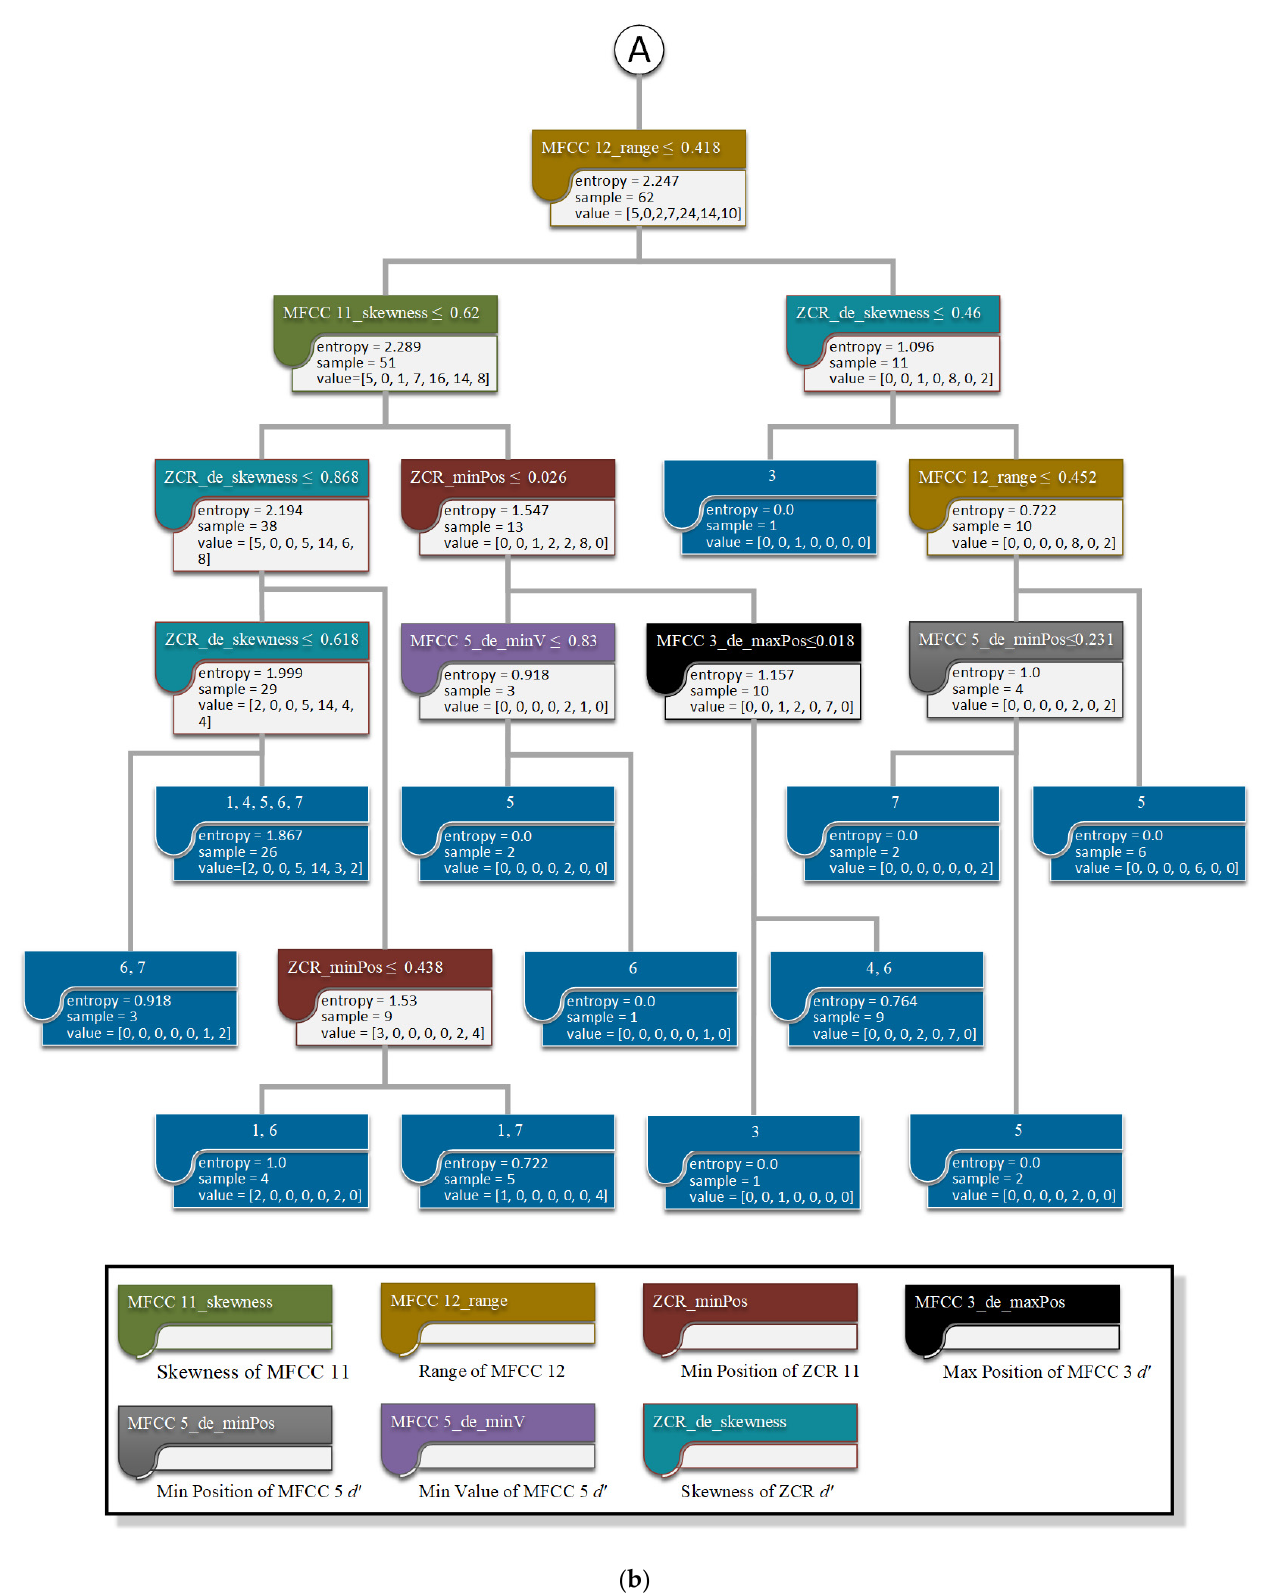
Figure 7. Visualization of the developed decision tree of Model_P02 using 7 ANOVA-screened features. ( a ) Part one of Figure 7; ( b ) Part two of Figure 7.